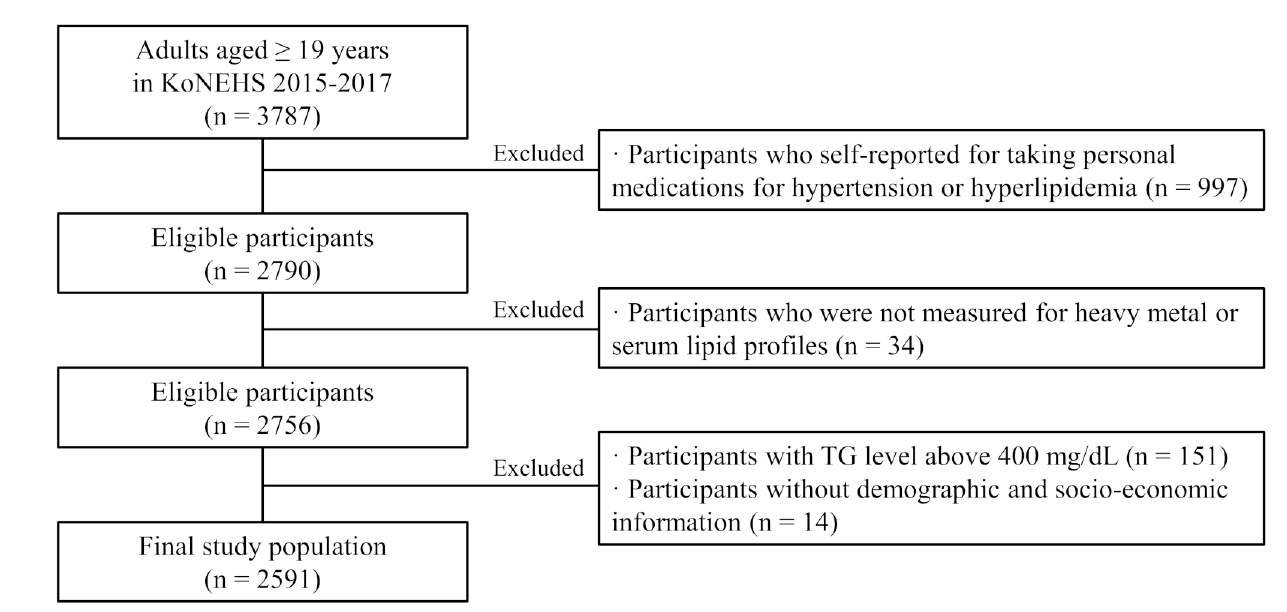
Figure 1. Participant flow chart of Korea National Environmental Health Survey (KoNEHS) 2015–2017 data available in this